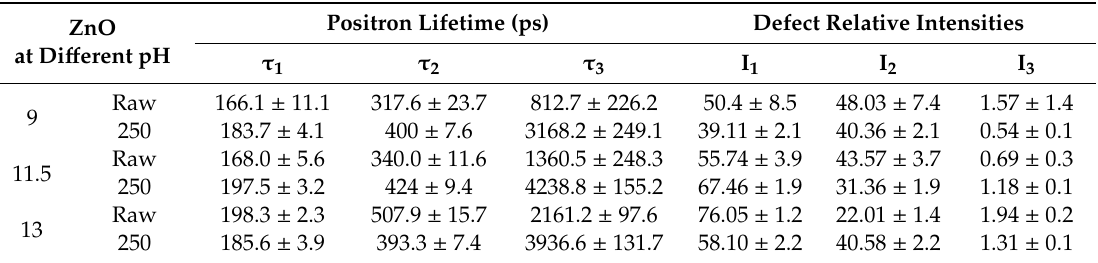
Figure 5. Positron lifetime spectrum of ZnO powder synthesized at different pH of 9.0, 11.5, and 13.0 ( a ) dried at 80 °C for 24 h, ( b ) dried at 250 °C for 5 h. Table 1. Positron annihilation lifetimes ( τ ) and corresponding intensities (I) of ZnO powder synthesized through coprecipitation route at different pH, dried at 80 °C @24 h and 250 °C @5 h, respectively.